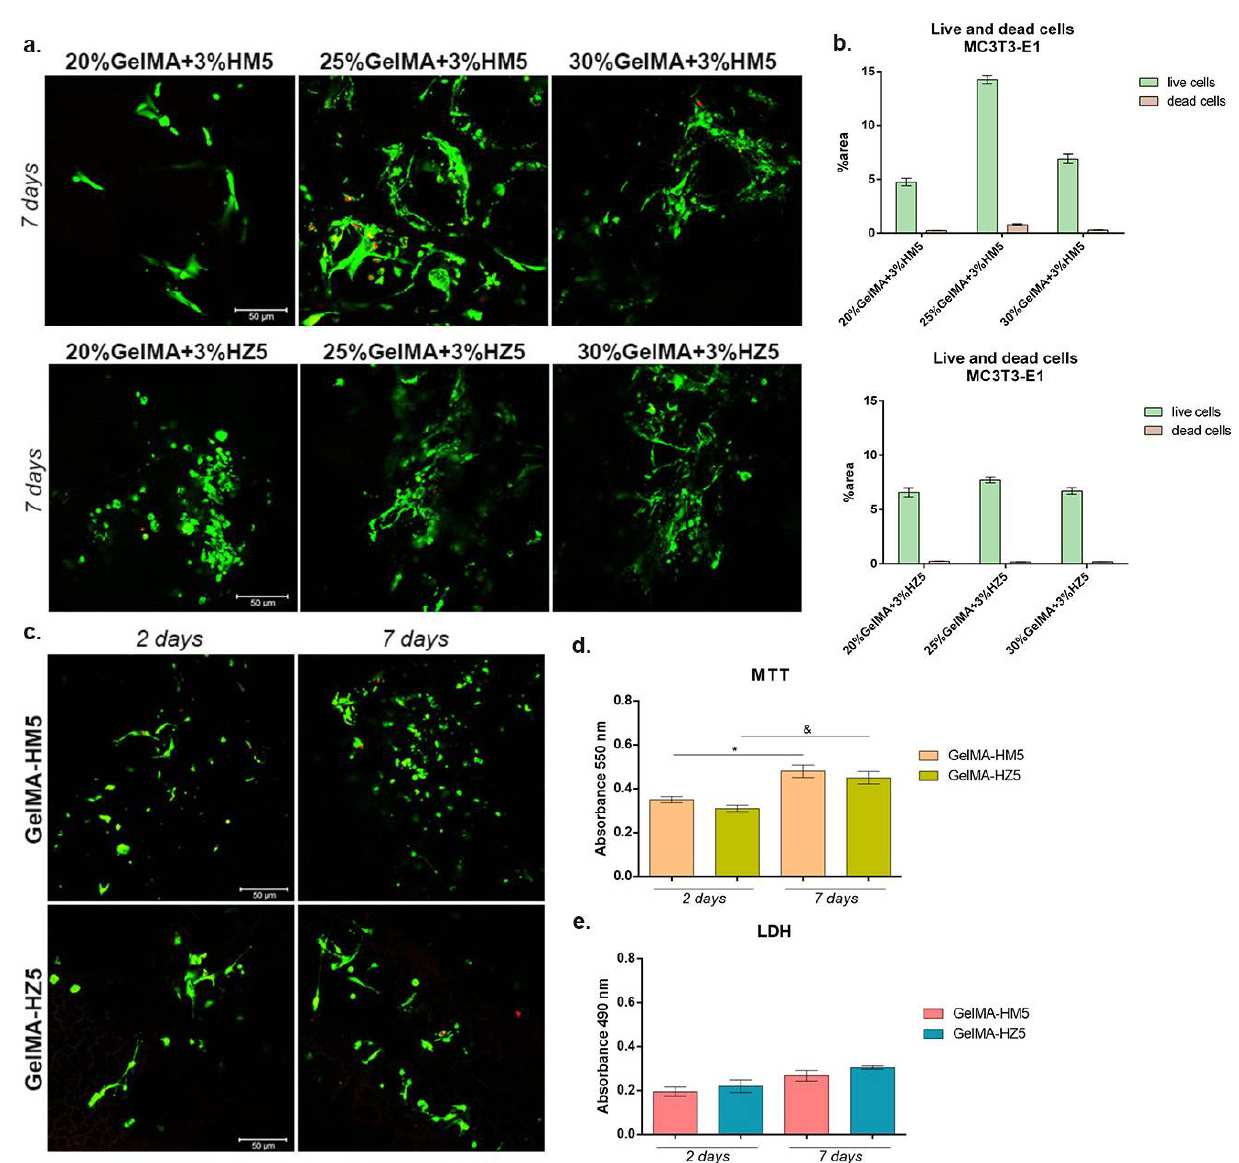
Figure 17. ( a ) Live/dead fluorescent coloration coupled with confocal microscopy, indicating live cells (green) and dead cell (red) put in contact with 20%, 25%, and 30% GelMA-enriched scaffolds. Scale bar size is 50 µm. ( b ) Quantification of green fluorescence (live cells) and red fluorescence (dead cell nuclei) levels in all composites. ( c ) Qualitative assessment of living cells (green) and dead cells (red) in contact with GelMA-HM5 and GelMA-HZ5 printed scaffolds. Scale bar size is 50 µm. ( d ) Biocompatibility assessment by MTT test after seven days of culture in contact with printed samples GelMA-HM5 and GelMA-HZ5. Statistical significance: */& p < 0.05. ( e ) Cytotoxic level registered for GelMA-HM5 and GelMA-HZ5 scaffolds indicated by LDH test at two and seven days of culture.